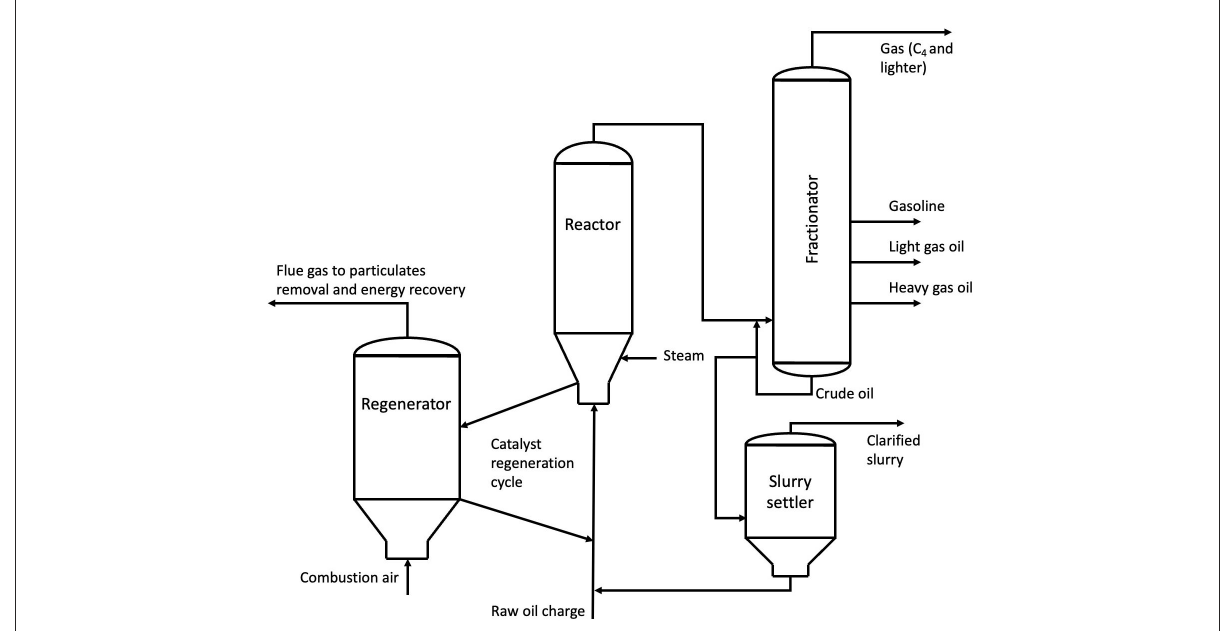
FIGURE4 A schematic showing the FCC reactor configuration (after Gholami et al.,